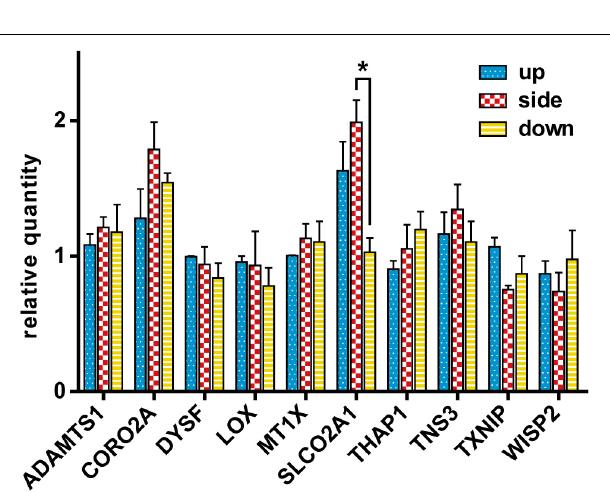
FIGURE 8 | The comparison of gene expression of the cells in the up, side, and down configurations. The relative quantity of each gene was assayed using qRT-PCR and normalized to the 18S rRNA level. For each configuration n = 3. The data were expressed as the mean ± S.E.M. * p <